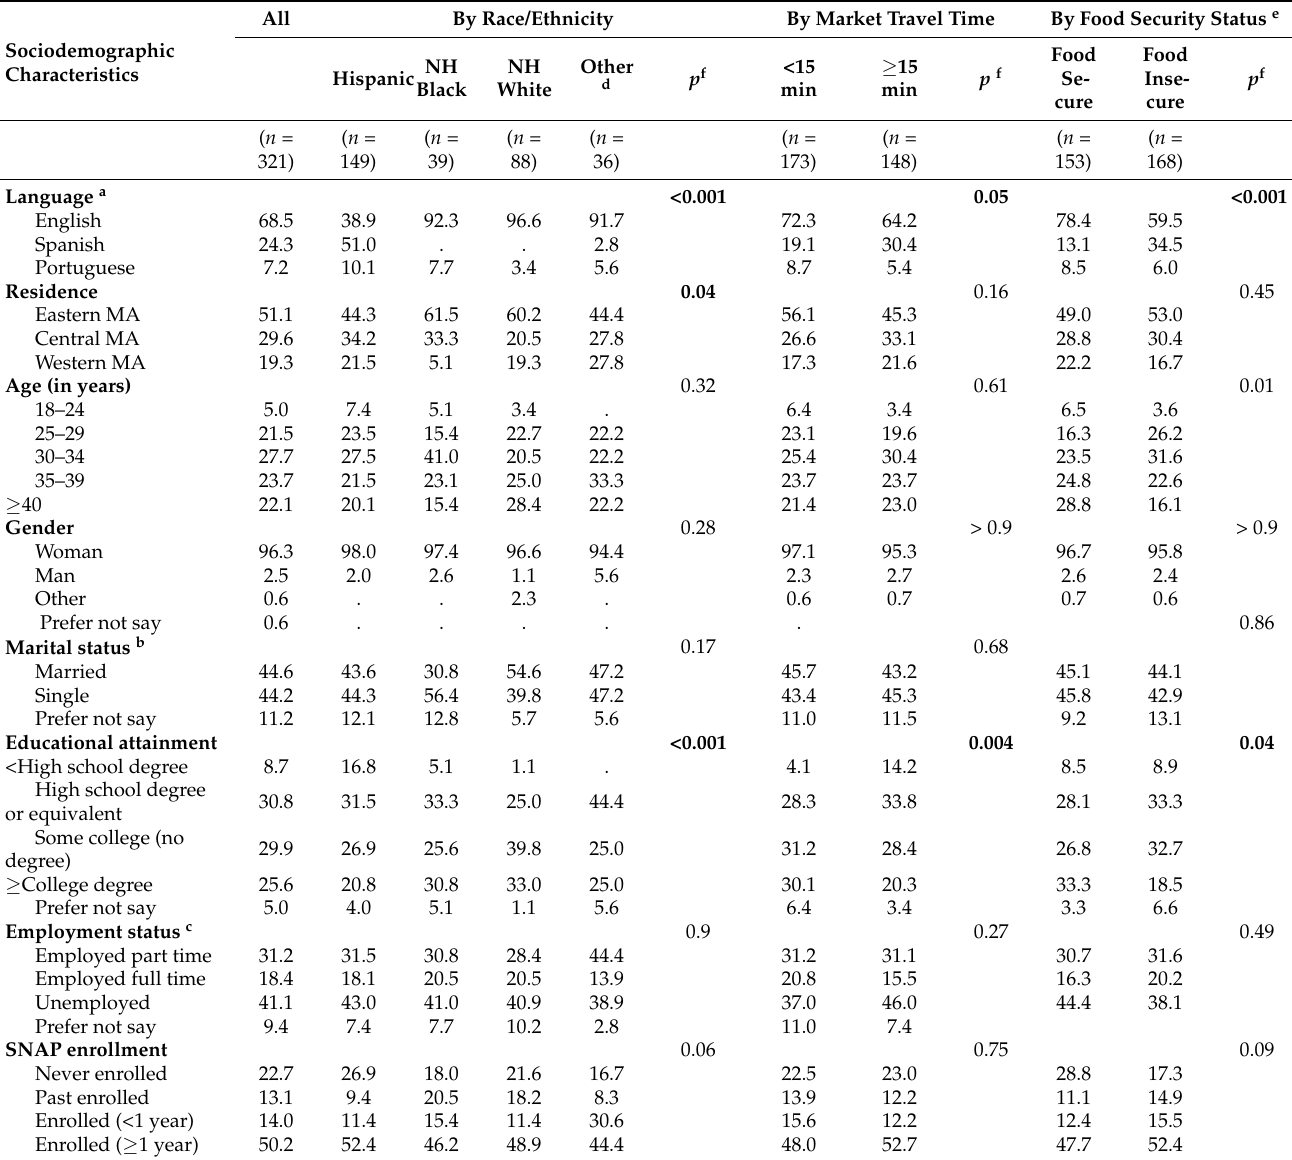
Table 1. Sample Characteristics of Survey Participants, by Race/Ethnicity, Average Market Travel Time, and Food Security Status ( n = 321 MA WIC caregivers,